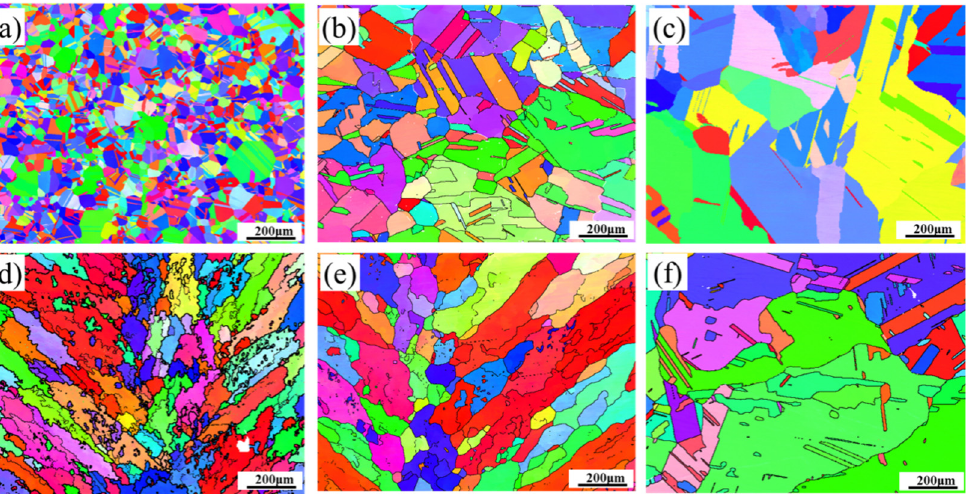
Figure 3. EBSD analysis of the welded joints for as-welded ( a , d ), FH ( b , e ), and TS ( c , f ) samples at 1100 °C (base metal ( a – c ) and weld metal ( d – f )).